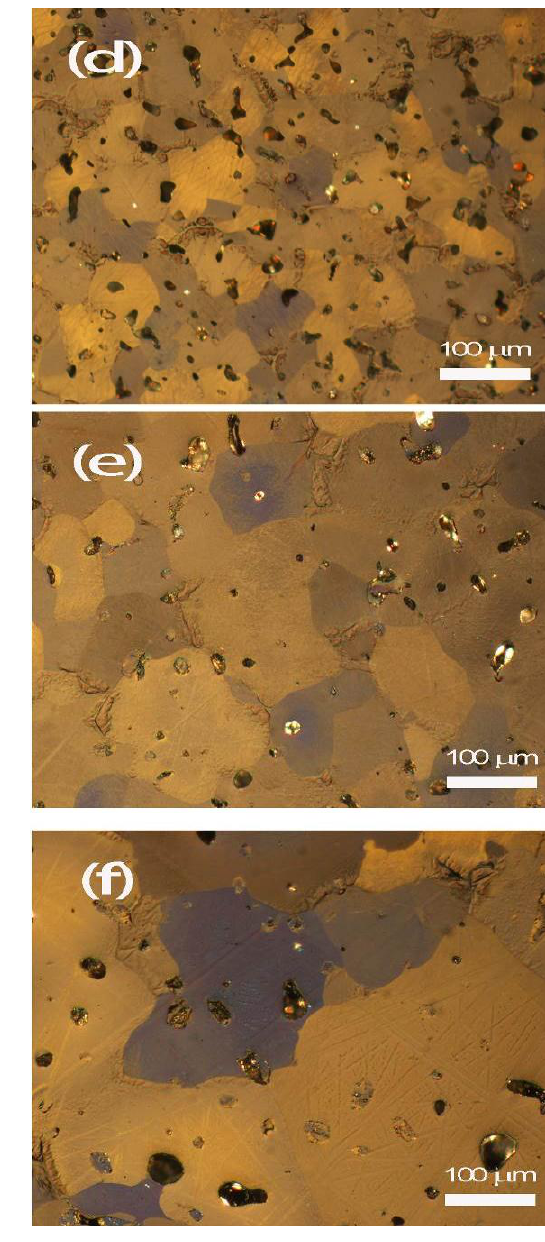
Figure 4. Microstructure of the cross sections of sintered small compacts at various sintering conditions. The micrographs were taken under polarized light microscopy. The compacts were sintered at various temperatures for different holding times: ( a ) 1100 ◦ C/4 h; ( b ) 1250 ◦ C/4 h; ( c ) 1400 ◦ C/4 h; ( d ) 1100 ◦ C/8 h; ( e ) 1250 ◦ C/8 h; and ( f ) 1250 ◦ C/8